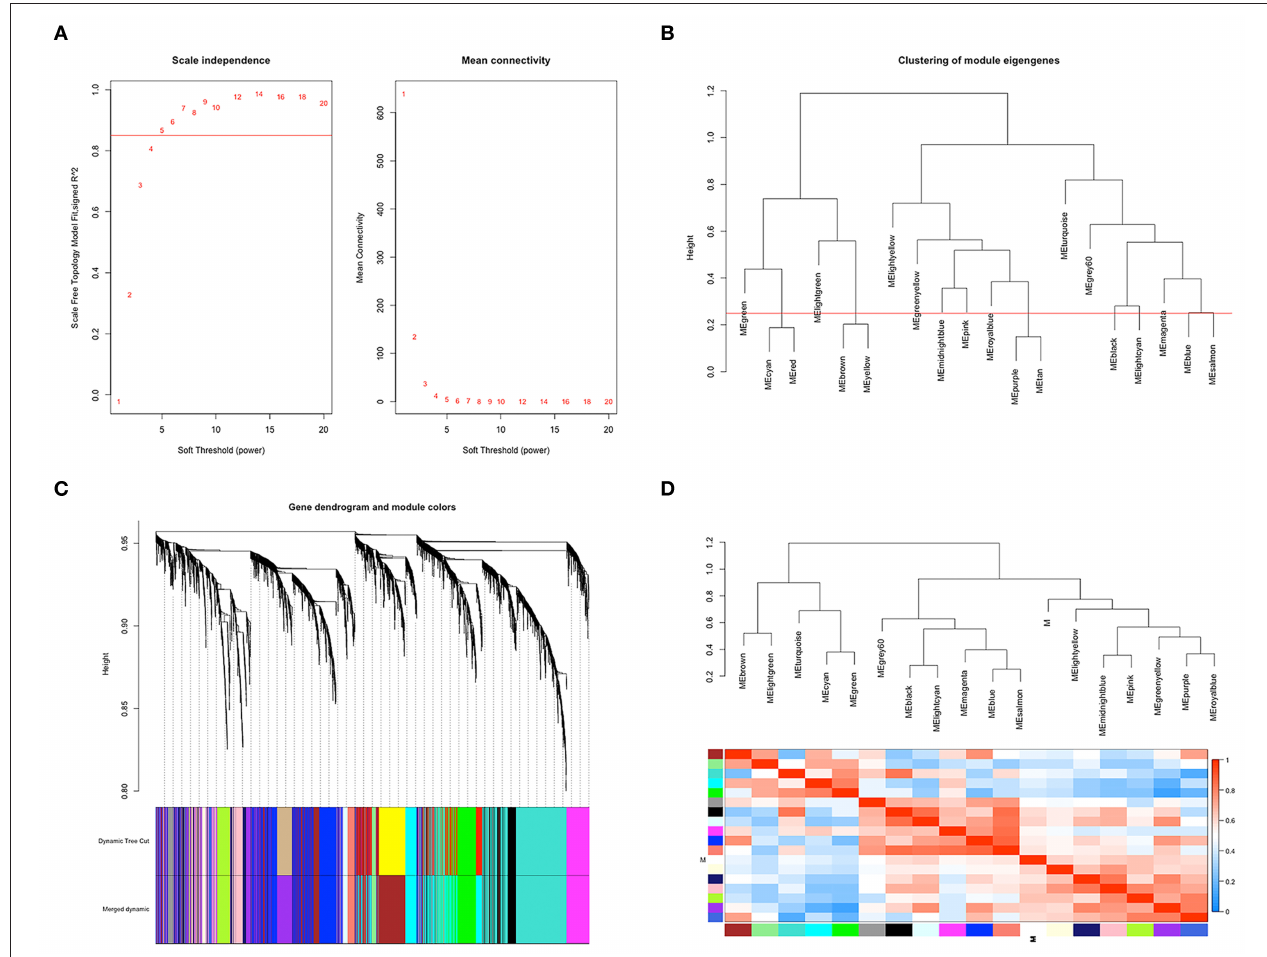
FIGURE 2 | Co-expression network construction based on TCGA-BLCA mRNA data. (A) The analysis of topology for soft threshold powers and β = 5 (scale-free R 2 = 0.85) was set as the soft thresholding for further adjacency calculation. (B) Clustering dendrograms were cut at a height of 0.25 to identify the similar modules. (C) The original 20 modules and merged 17 modules were displayed at top and bottom under the clustering dendrogram. (D) An eigengene network heat map showed the correlation between each module, and modules with close connectivity were clustered